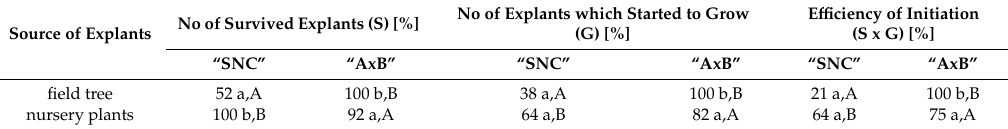
Table 2. Initiation of mountain mulberry ‘Kenmochi’ in vitro cultures on standard (AxB) and cytokinin-free (SNC) media.